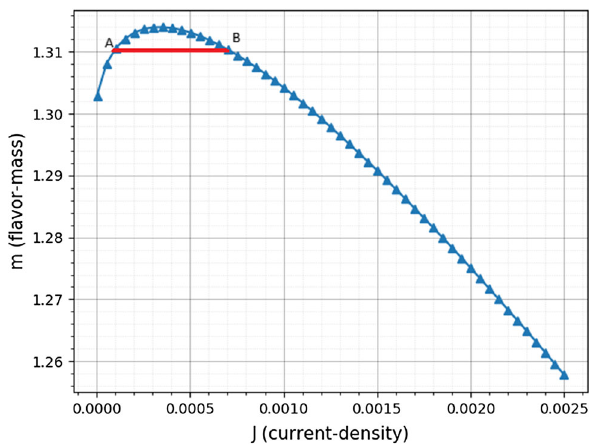
Fig. 1 m - J curve for E β = 0 . 1 and T = 0 . 45015 and β = 1. the maximum value is located at m max = 1 .